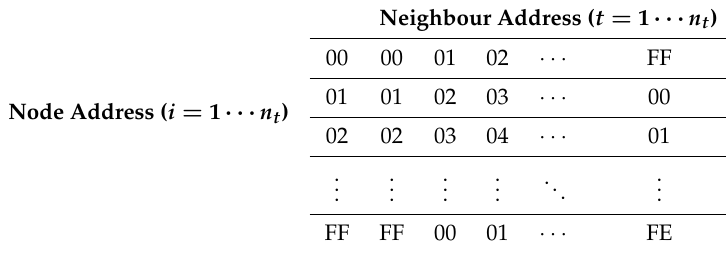
Table 2. Hexadecimal coefficients in field size F 2 8